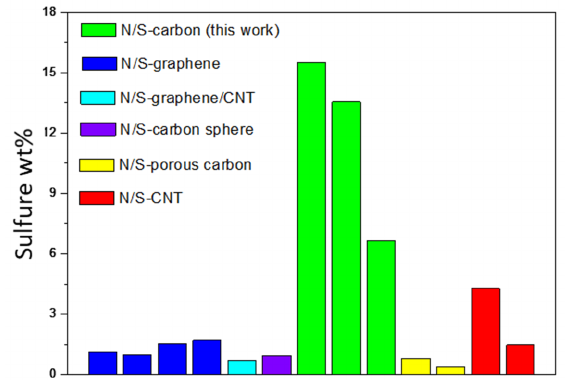
Figure 9. Comparison of our synthesised carbon materials with other literature reported carbon materials based on the S-doping percentage.